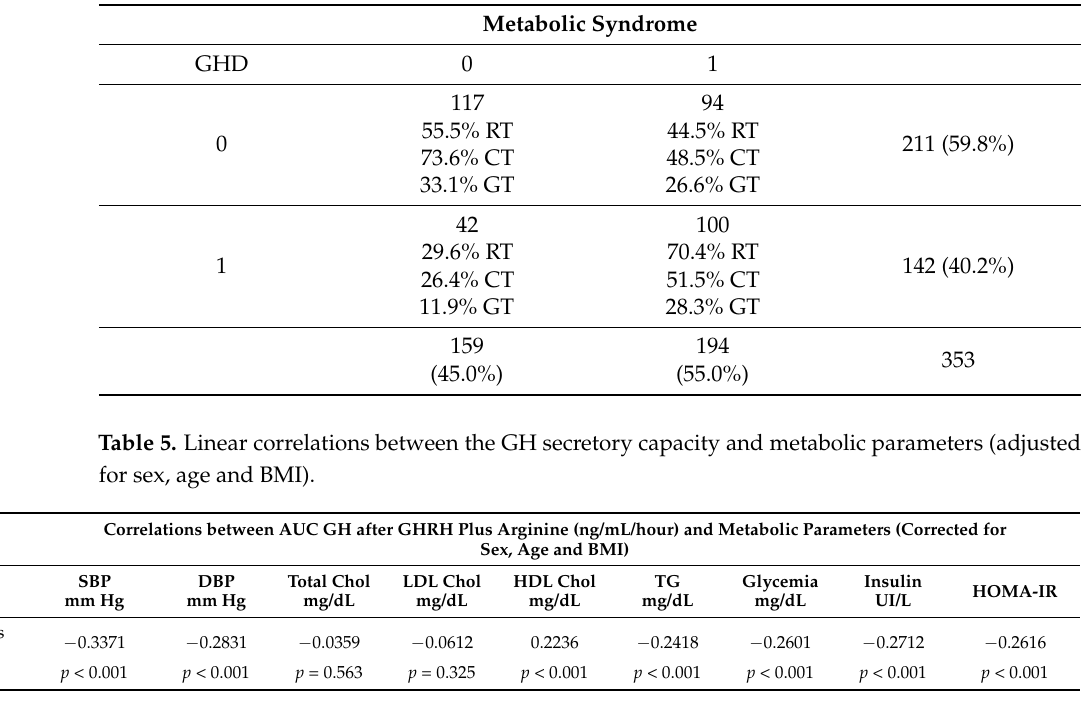
Table 4. Frequencies chart of metabolic syndrome and GHD in the population studied. Chi-squared test, p < 0.0001.